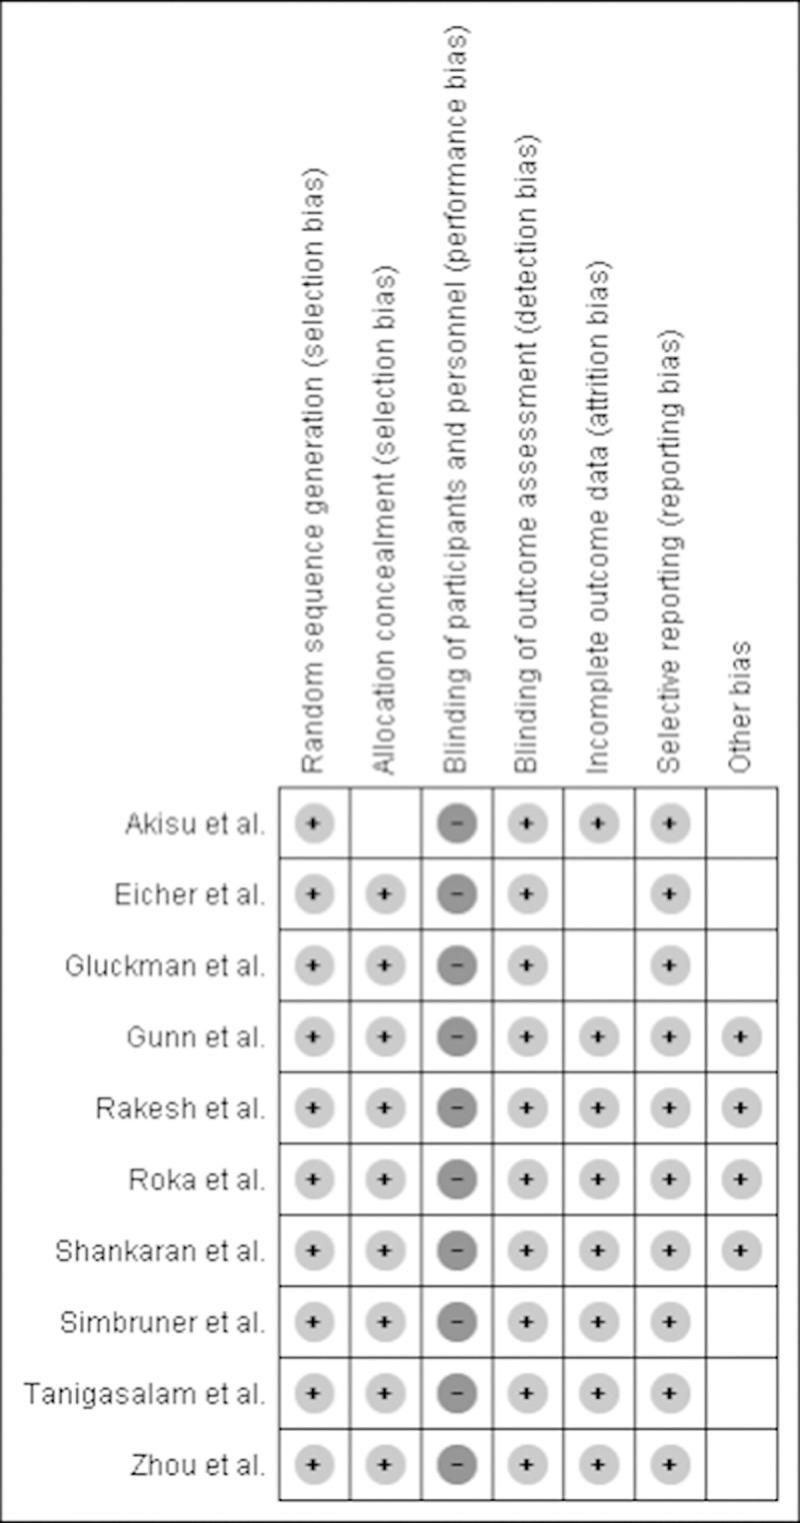
Risk of bias assessed in the included randomized controlled trials.Plus-sign represents ‘low risk’, minus-sign represents ‘high risk’, empty represents ‘unclear risk’.